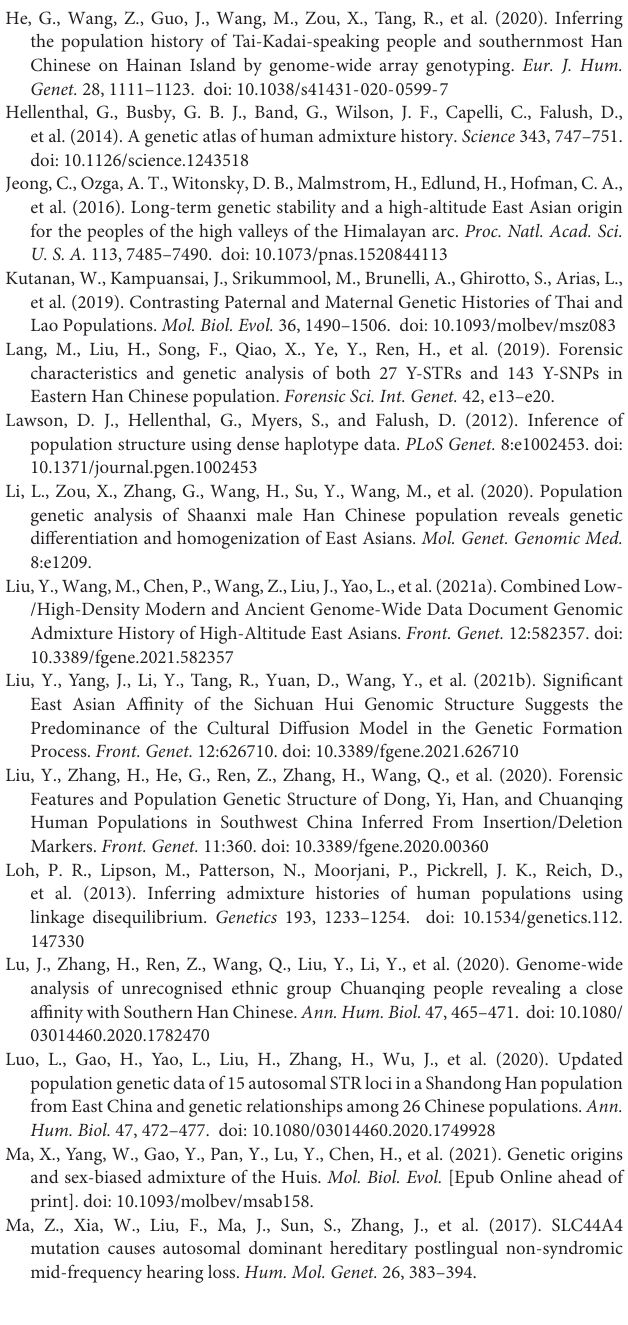
Supplementary Figure 1 | The distribution of cross-validation